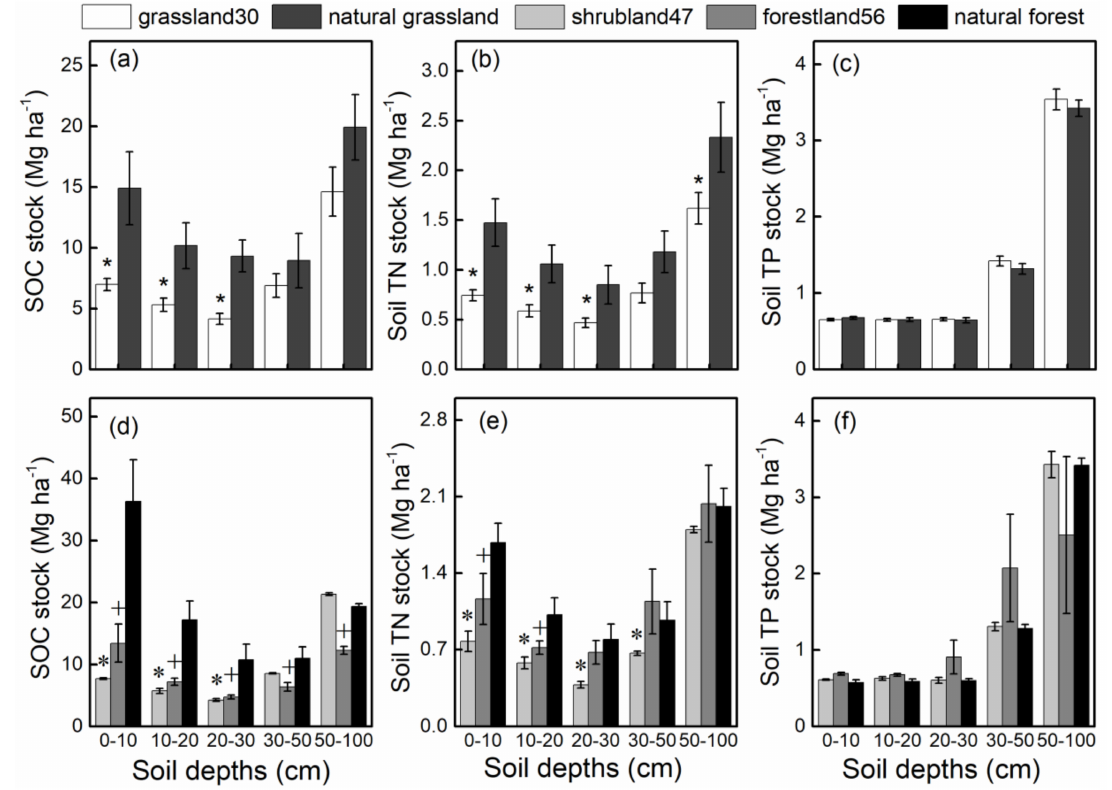
Figure 3. Stocks of soil organic carbon (SOC), soil total nitrogen (TN), and soil total phosphorus (TP) at different soil depths in grassland at 30 years compared to those of natural grassland, and those of shrubland at 47 years and forestland at 56 years compared to those of natural forest. Note: values are mean ± standard error. ( a – c ) means the SOC stock, Soil TN stock and Soil TP stock at different soil depths in grassland30 compared to those of natural grassland. ( d – f ) means the SOC stock, Soil TN stock and Soil TP stock at different soil depths in shrubland47 and forestland56 compared to those of natural forest * denotes significant differences between the natural grassland and grassland at 30 years after vegetation restoration ( p < 0.05). * denotes significant differences between the natural forest and shrubland at 47 years after vegetation restoration ( p < 0.05). + denotes significant differences between the natural forest and forestland at 56 years after vegetation restoration ( p <